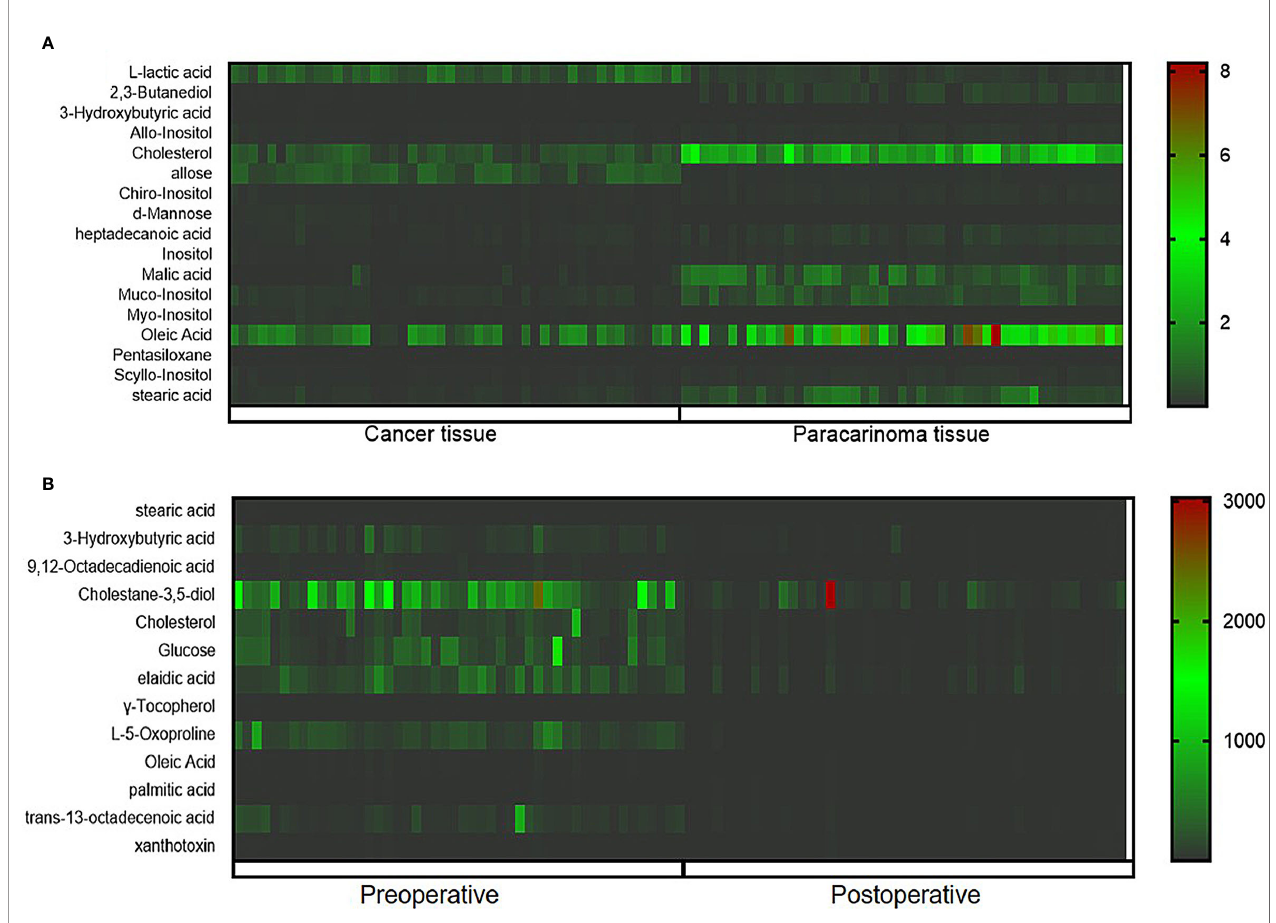
FIGURE 5 | Heatmap of differential metabolites between cancer tissue and paracarcinoma tissue samples (A) and preoperative and postoperative serum of 2-week samples (B)